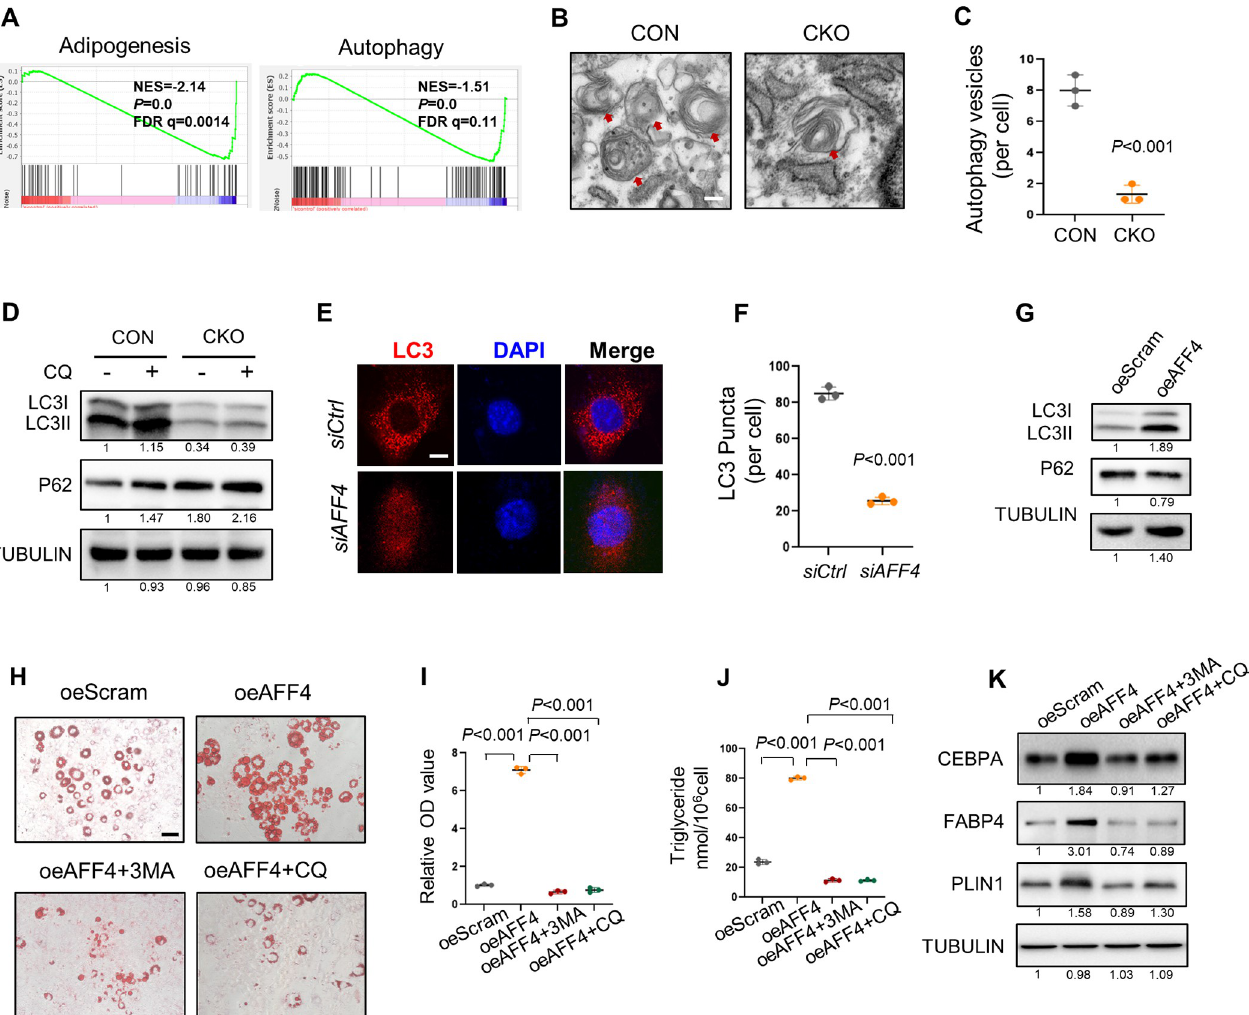
Fig 4. AFF4 controls adipogenesis via autophagy. (A) GSEA enrichment of adipogenesis and autophagy related pathway in AFF4-deficient hMSCs. (B, C) Representative TEM images and quantification of autophagy vesicles in preadipocytes from CON and CKO mice. Scale bar, 500 nm. n = 3. (D) Western blot analysis of autophagy-related proteins from primary preadipocytes of CON and CKO mice. CQ, chloroquine. (E, F) Representative immunofluorescent images and quantification of LC3 puncta in siCtrl and siAFF4 hMSCs. Scale bar, 25 μ m. n = 3. (G) Western blot analysis of autophagy related markers in AFF4 overexpressing and Ctrl 3T3-L1 cells. (H-K) Autophagy inhibitors corrected augmented adipogenic differentiation of AFF4-overexpressing cells. (H) Representative images of oil red o staining in the presence of 3-MA and CQ. Scale bar, 25 μ m. 3MA, 3-methyladenine. CQ, chloroquine. (I) Quantification of oil red o staining, absorbance at 518 nm. n = 3. (J) Quantification of triglyceride. n = 3. (K) Western blot of adipogenic markers in the presence of 3-MA and CQ. All quantified data are presented by as mean ± SD. The P values were calculated by two-tailed Student’s t-test (C, F) or one-way ANOVA followed by the Tukey’s post hoc test (I,